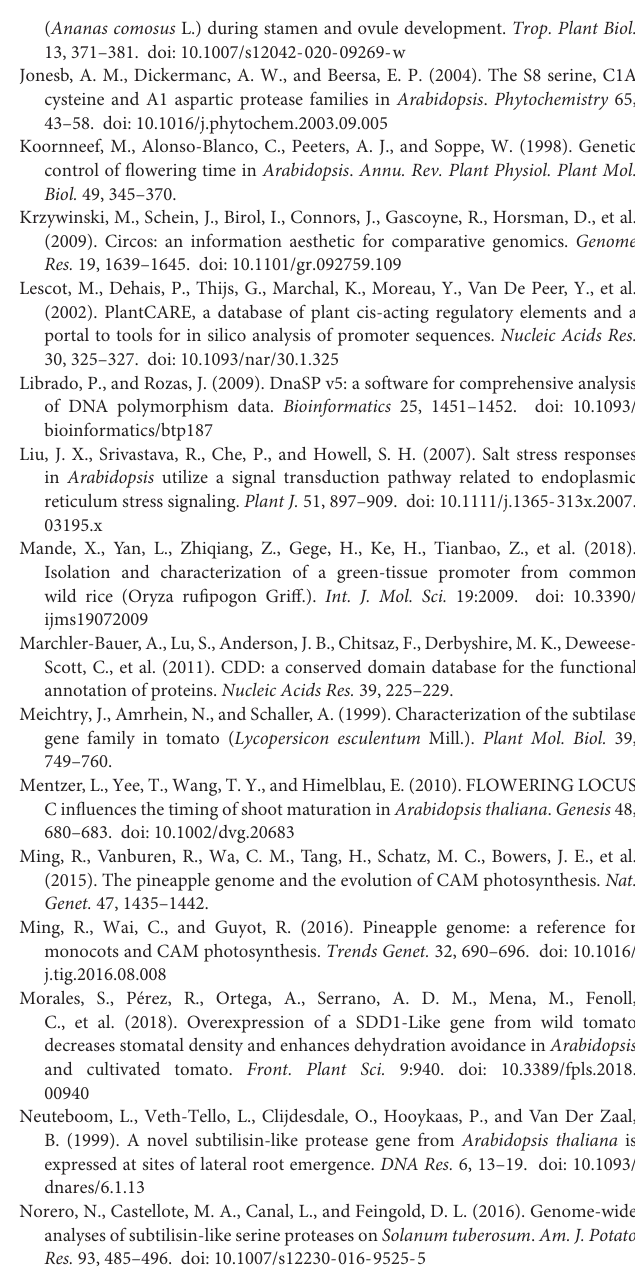
Supplementary Table 1 | Detailed information of pineapple SBTs, including sequenced ID, chromosome locations, isoelectric point (pI), molecular weight (KD), protein length and function domains. Supplementary Table 2 | The multilevel consensus sequence and description of 10 motifs. Supplementary Table 3 | The original data of Ka and Ks value. Supplementary Table 4 | The distribution of Cis-acting elements. Supplementary Table 5 | The original data of FPKM value. Supplementary Table 6 | Information about AcoSBT1.12 and genes encoding interacting